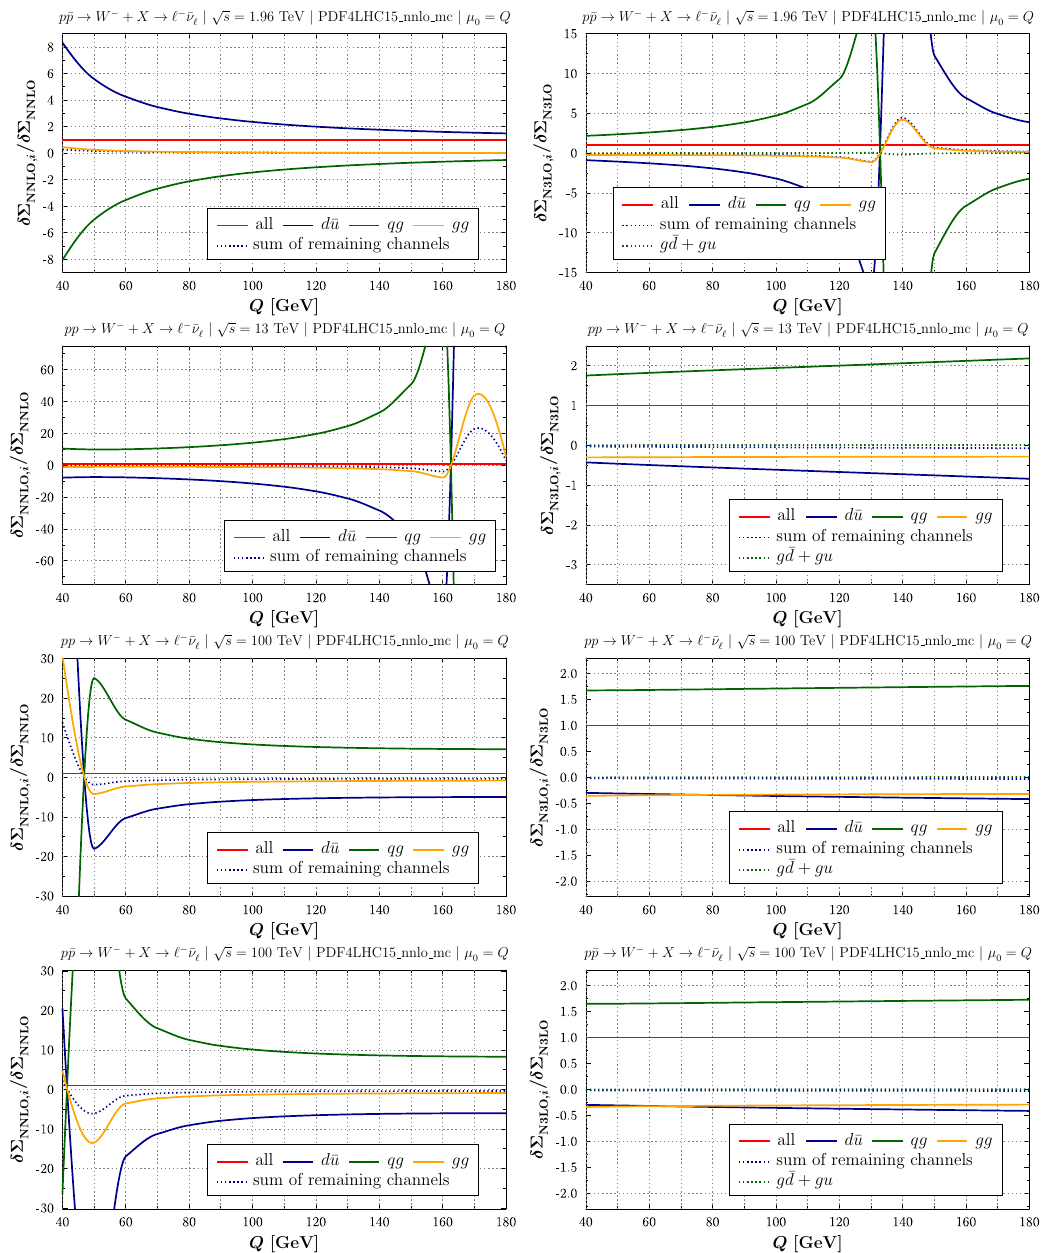
Figure 7 . Individual channels contributing to the invariant mass distribution for the production of an e − ν pair at different colliders, normalized to the total correction at NNLO (left panels) and e N 3 LO (right